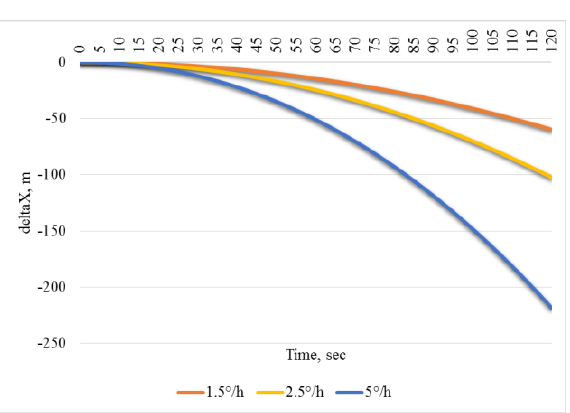
Figure 7. Gyroscopes errors accumulation along X axis